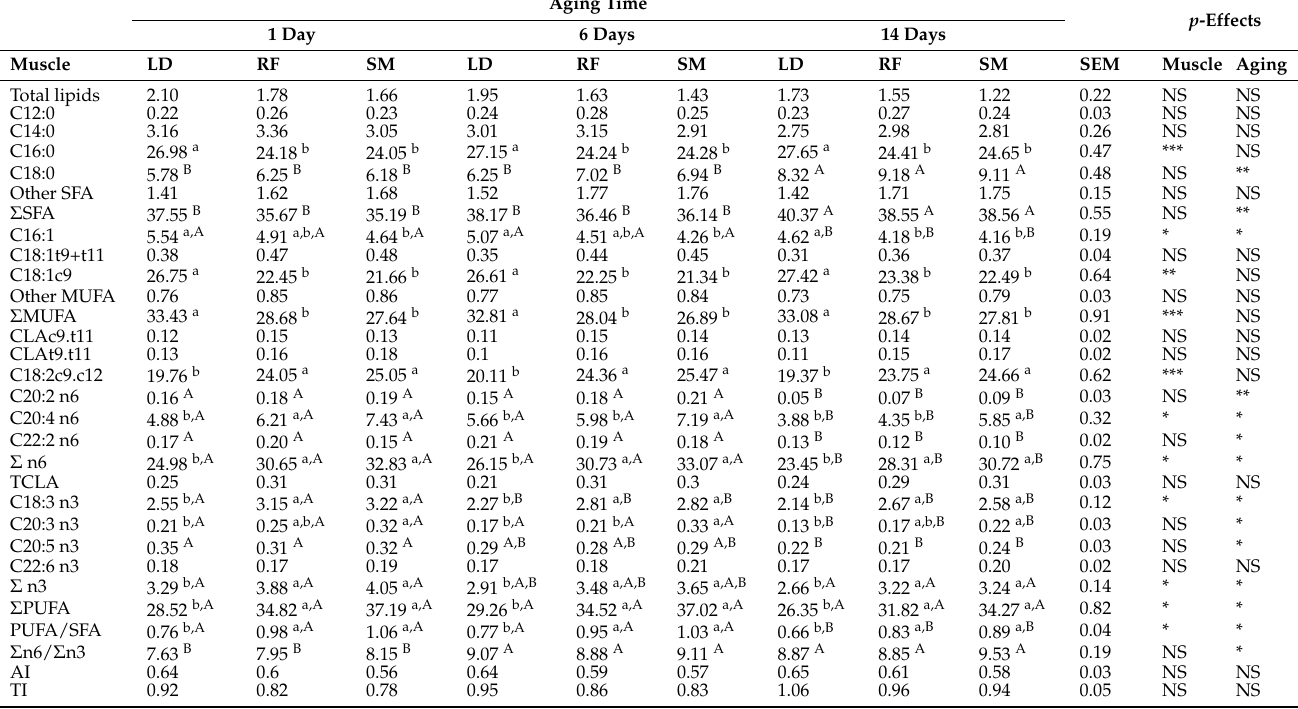
Table 2. Effect of muscle and aging time (days) on total lipids, fatty acid profile (g/100 g fatty acids), and health lipid indices of meat from donkey (means ±